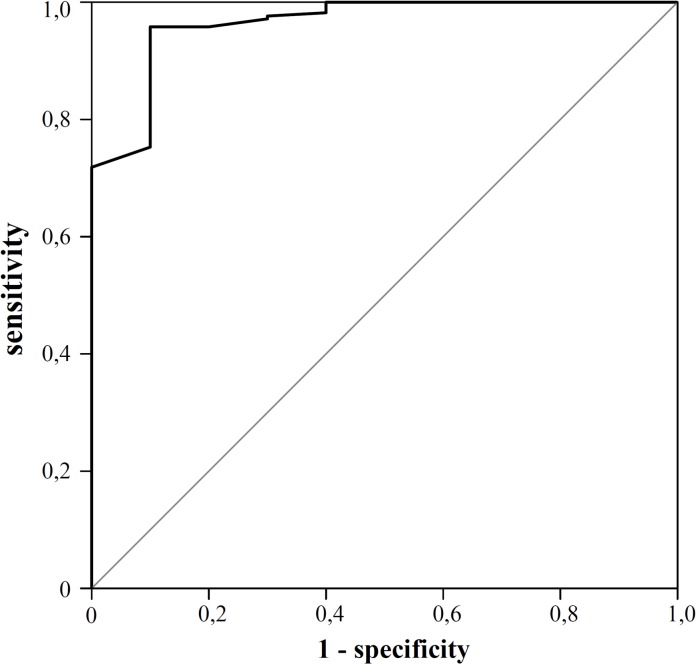
ROC curve for NDI with BSIDIII threshold< 70 versus ASQ3 total scores.Area under the curve 96% p<0.0001